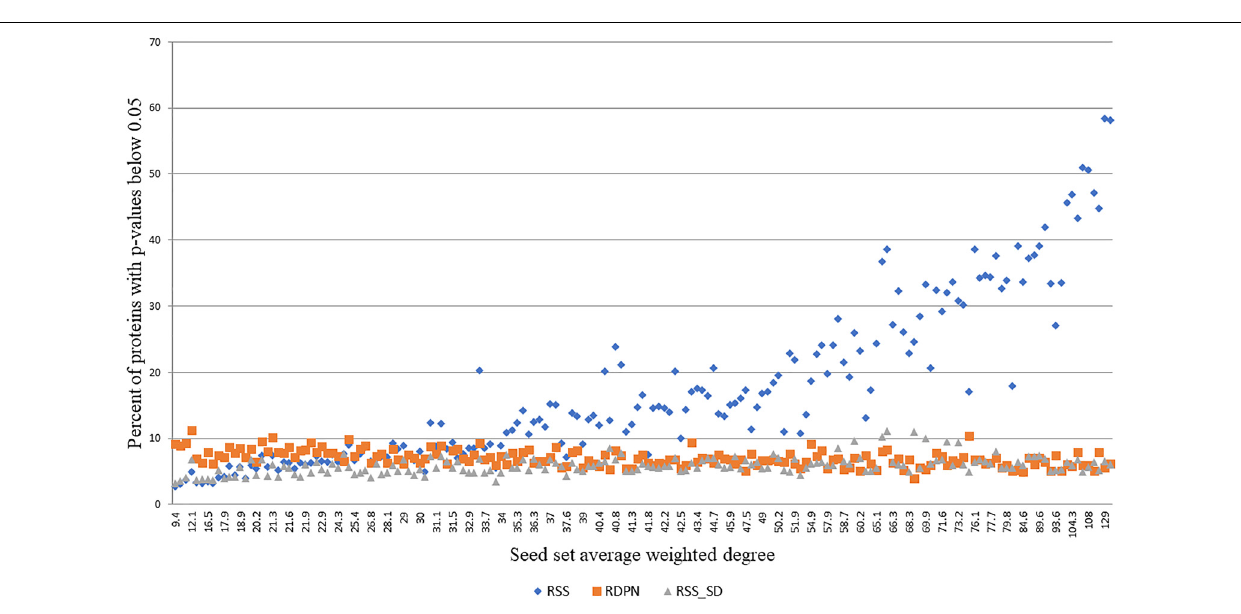
FIGURE 4 | Percent of proteins with p -values below 0.05 vs. seed set average weighted degree, using 173 seed sets from the Menche-OMIM data set (Menche et al.,